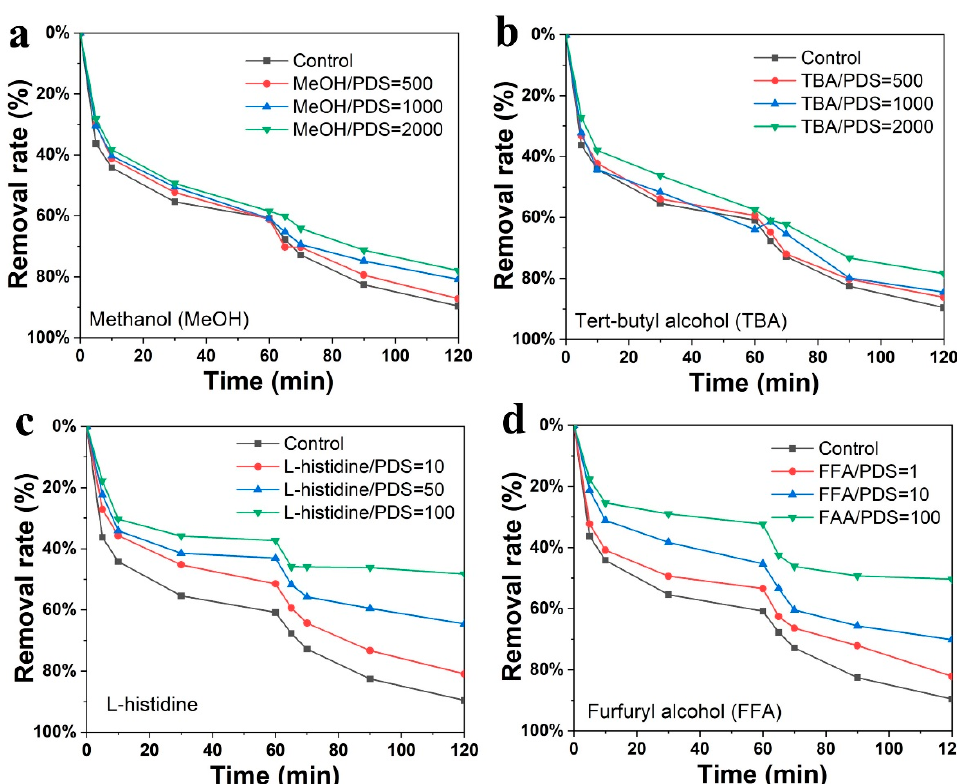
Figure 5. SMX degradation performances of EBC-K measured with different scavengers: ( a ) methanol (MeOH), ( b ) tert-butyl alcohol (TBA), ( c ) L-histidine, and ( d ) furfuryl alcohol (FFA). (Control, in the inset legends, represents the test without a scavenger, and the values represent the molar ratio between the scavenger and the